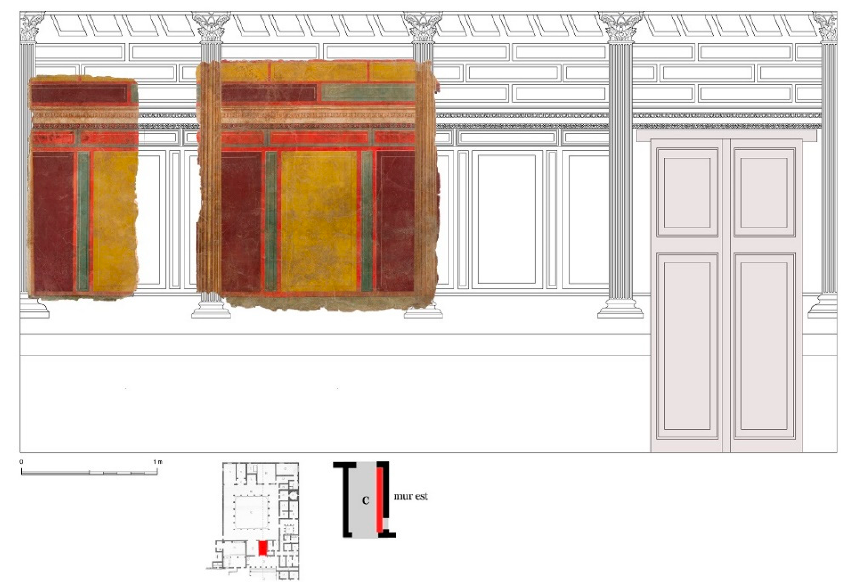
Figure 7. Eastern wall of the fauces from the Villa of Boscoreale, second style, restitution drawing of the wall’s overall design (by F. Ory; frescoes on display in Paris, Louvre MND 615 and 616); © F. Ory (with kind permission).